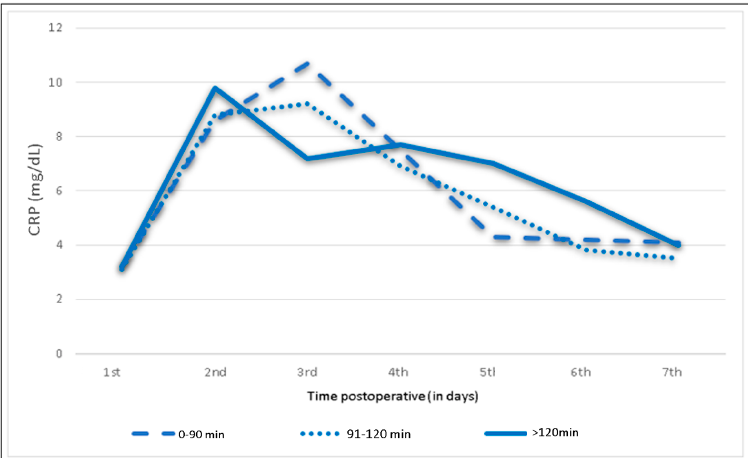
Figure 7. Mean C-reactive protein levels and trends following shoulder arthroplasty depending on the operating time. J. Clin. Med. 2020 , 9 , x FOR PEER REVIEW